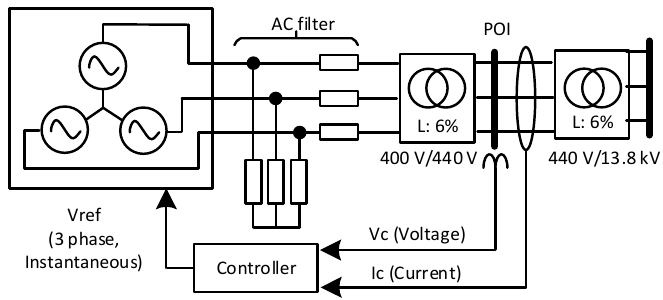
Figure 4. Average IBR model.